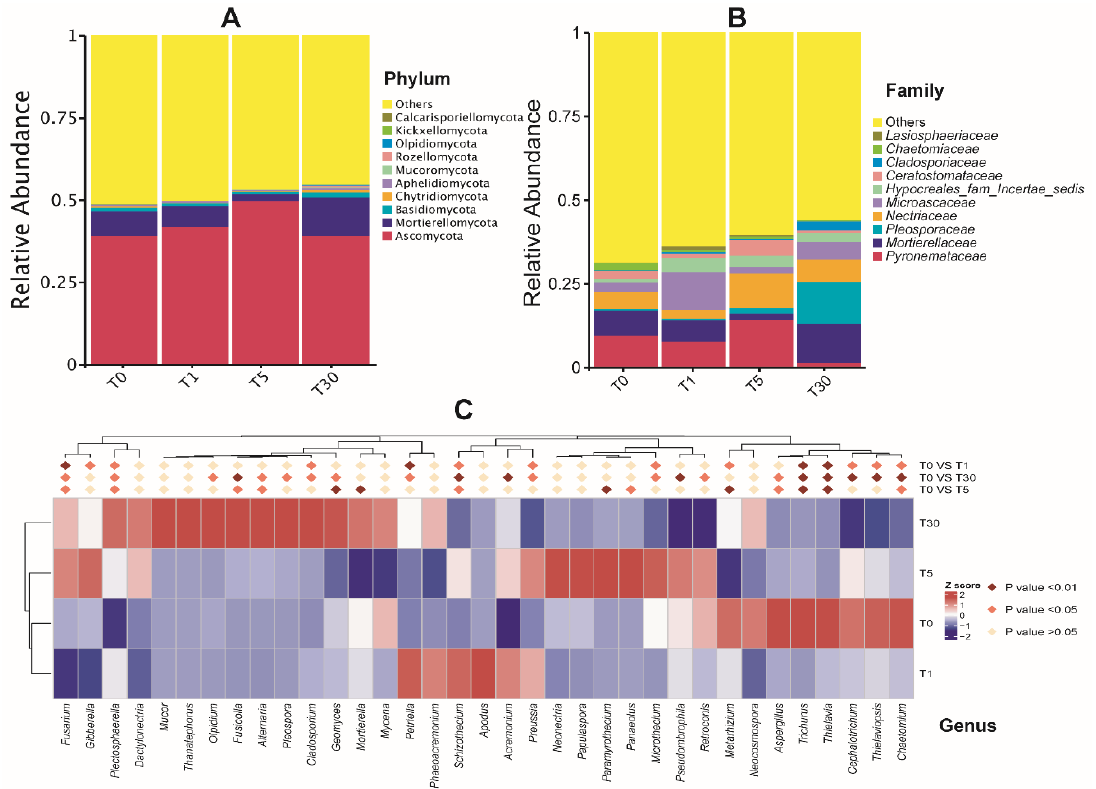
Figure 4. Taxonomic di ff erences of the fungal community among four groups of samples. ( A ) The top 10 phyla; ( B ) the top 10 families; ( C ) relative abundances of the top 20 genera were compared to T0 using MetaStat analysis.